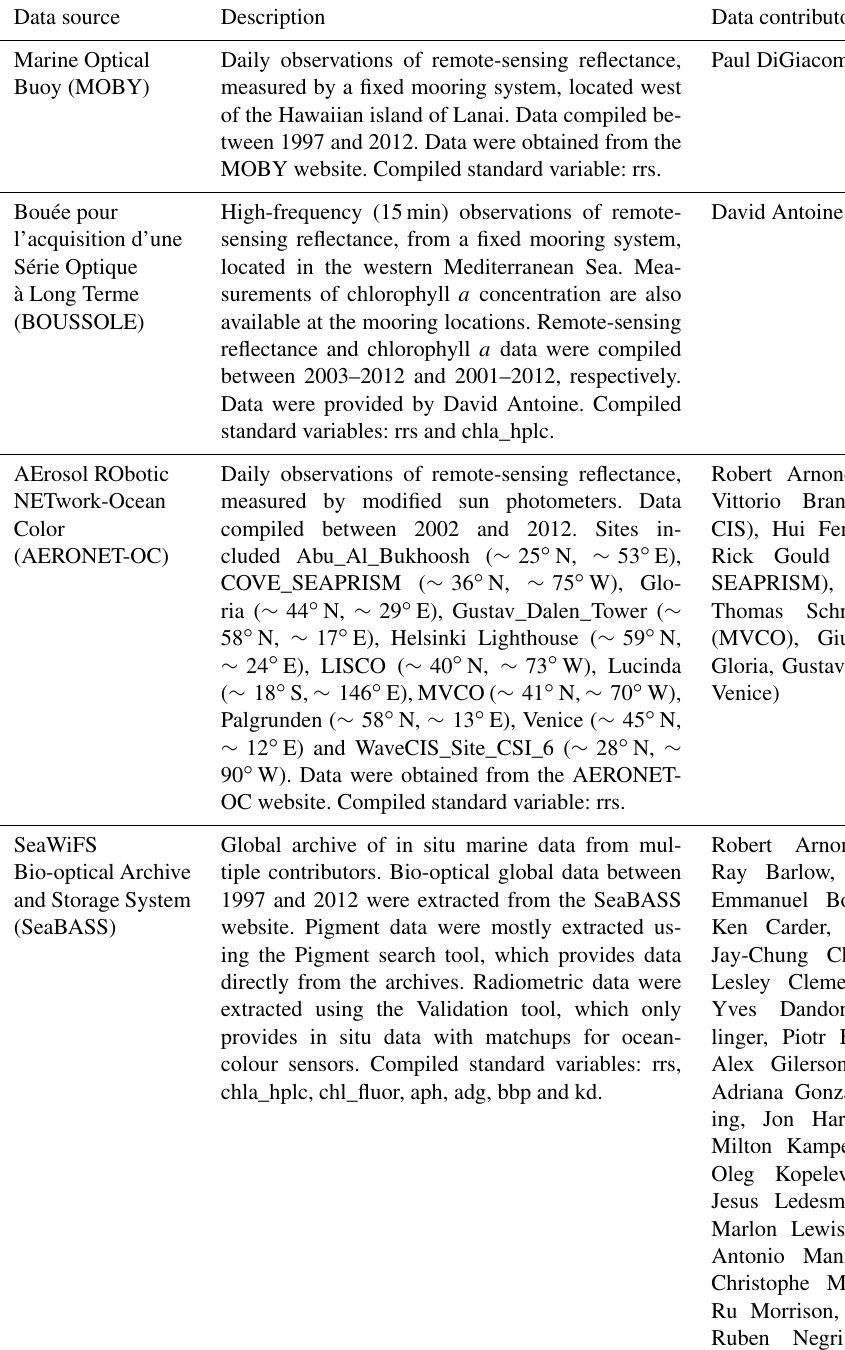
Table 2. Original sets of data and data contributors in the final